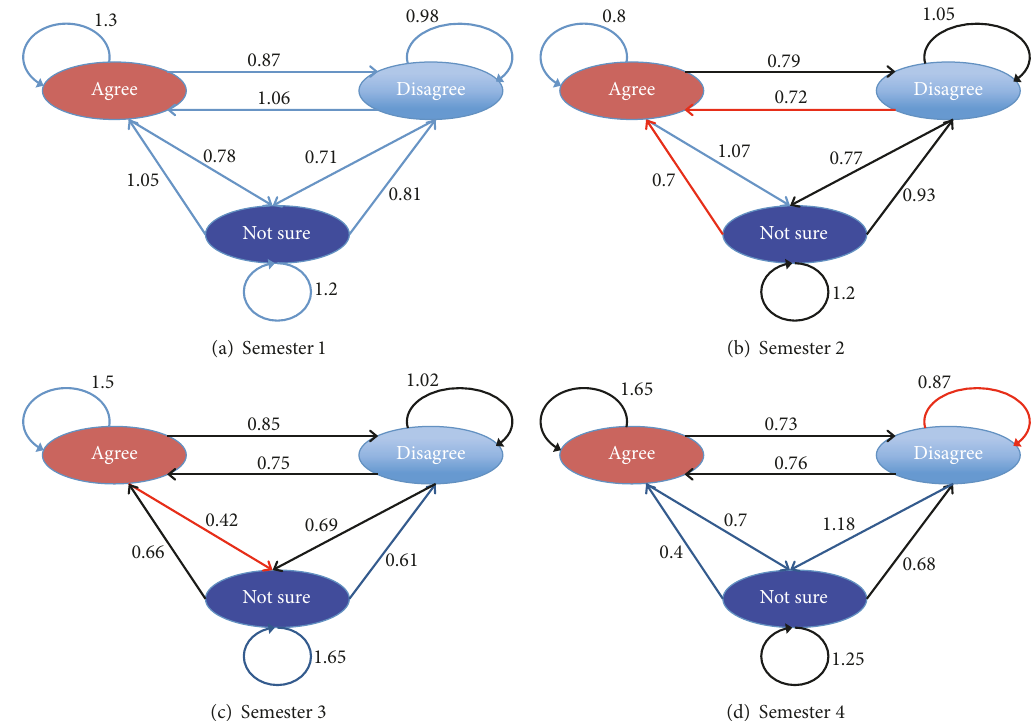
Figure 2: Views on gay marriage legalization, the average preference of nodes with a particular value for all values of the attribute.